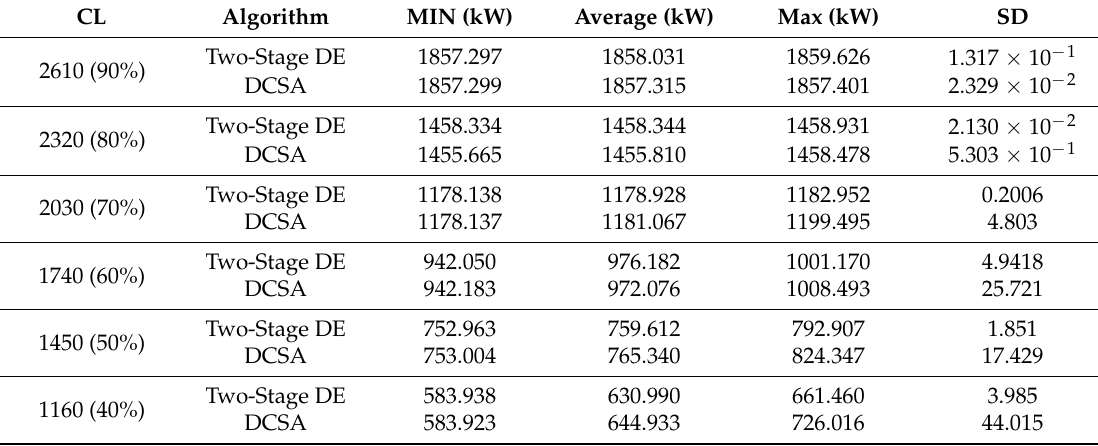
Table 5. Case study 2: comparison with DCSA.